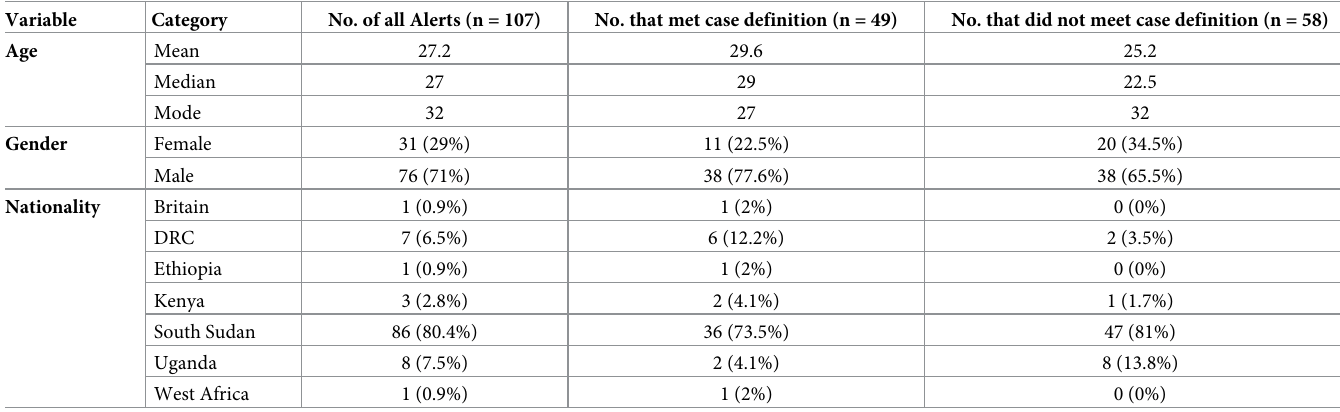
Table 2. Socio-demographic characteristics of EVD alerts in South Sudan–August 2018 to November 2019.